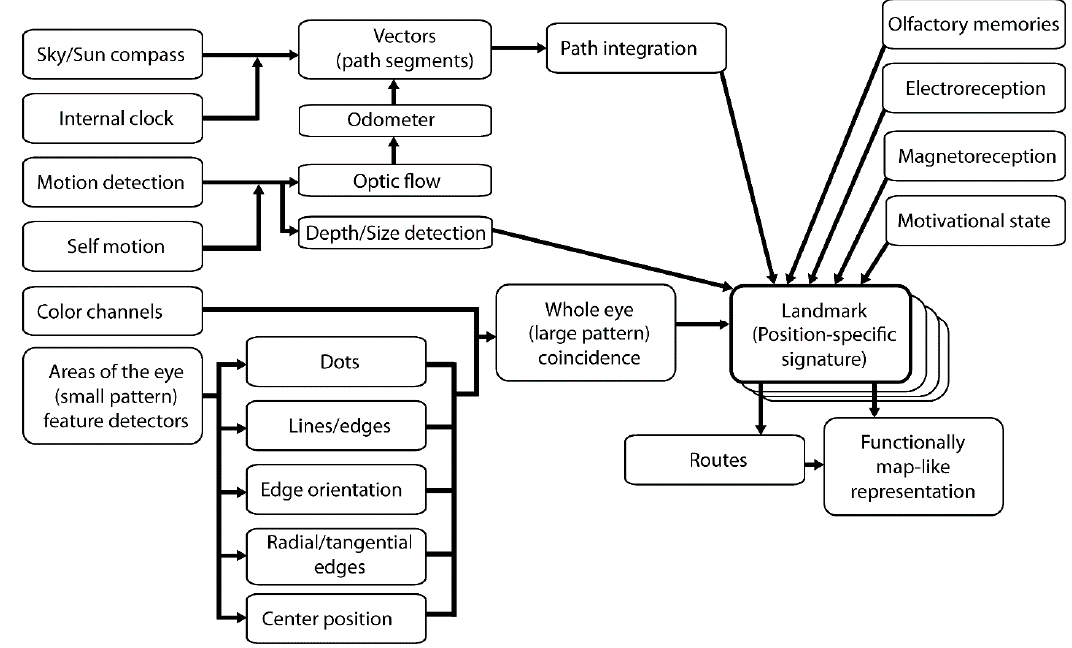
Figure 1. Different sensory stimuli and processing pathways for landmark detection and spatial navigation. At each location, the coincidence of multiple sources of sensory input is merged and combined into a signature. Each signature may be functionally attached to a navigational motor output such that a particular path is chosen by an animal in a specific motivational state. Multiple landmarks and routes may be combined to form a functional allocentric representation of the environment. Other cues and processing pathways play roles in guiding the navigation of bees, but we have limited our focus to the ones most studied.